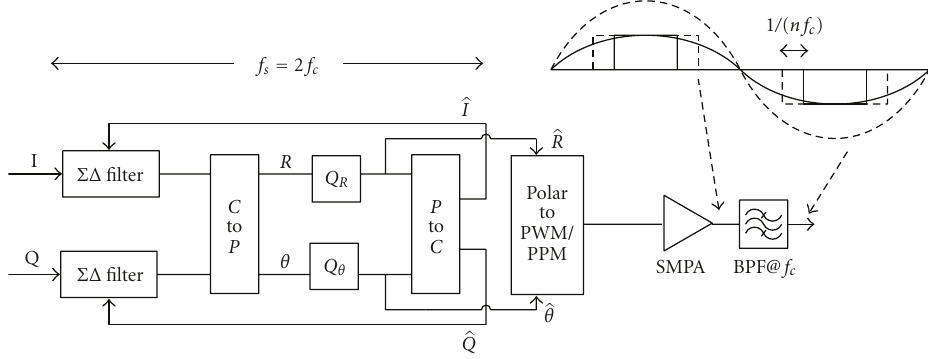
Figure 12: Block diagram of cartesian sigma delta.